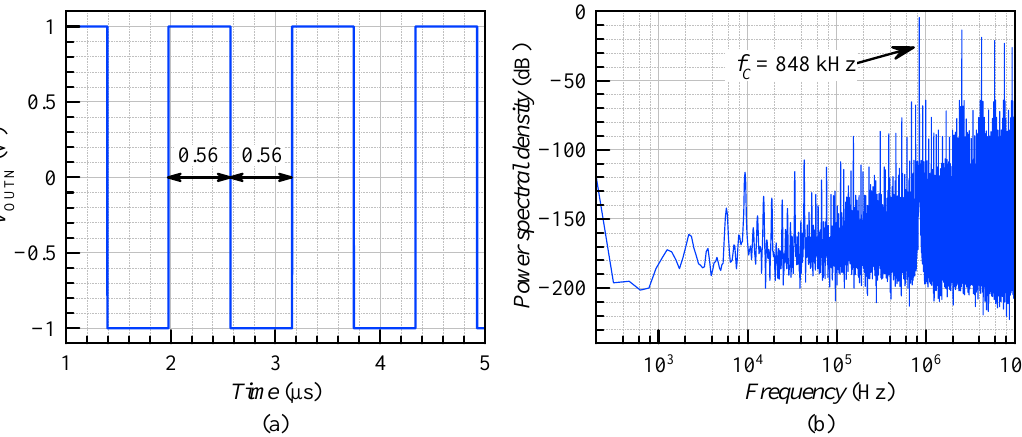
Figure 10. Post-layout simulation results: ( a ) timing diagram and ( b ) frequency spectrum of the ADSM for V IN = 0